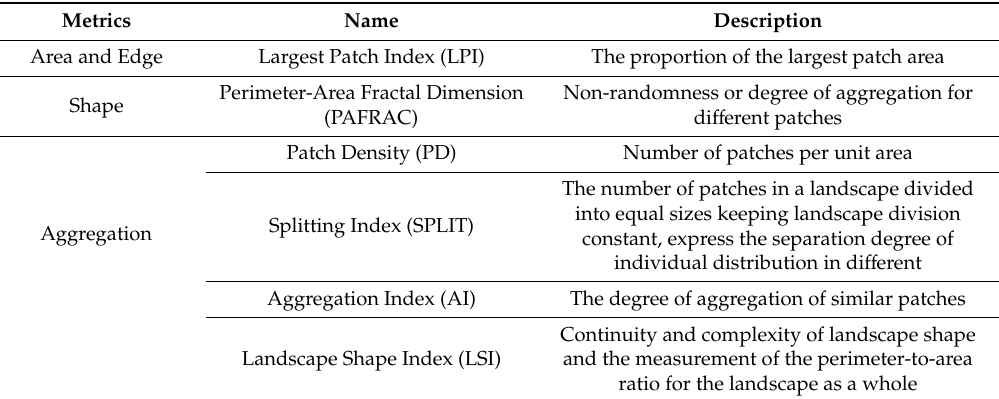
Table 1. Landscape pattern